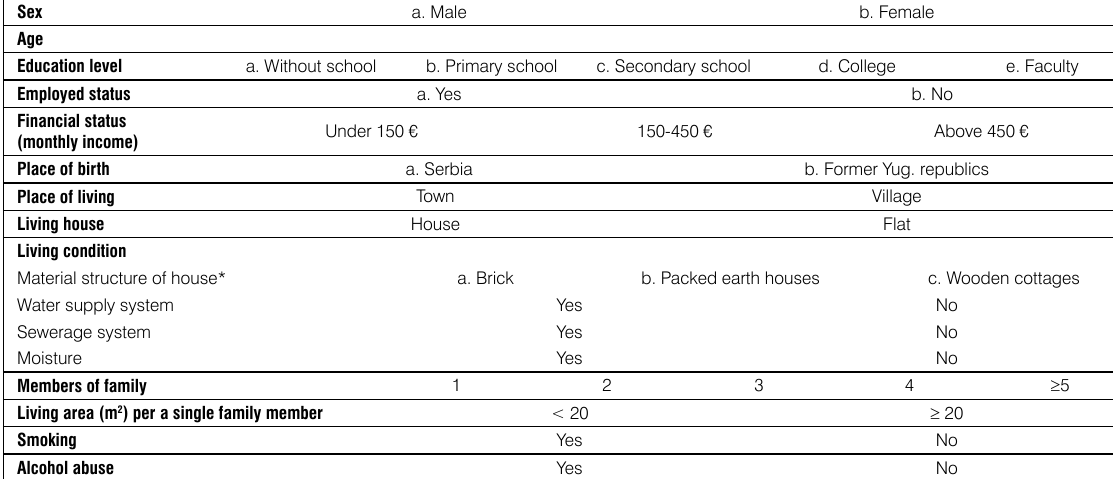
Figure 2. Questionnaire 2.